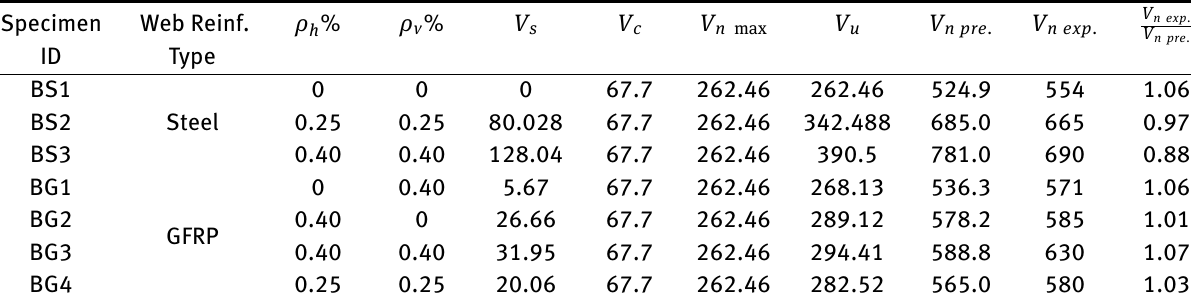
Table 11: Design of deep beams with traditional ACI design method (ACI 318R-99) [17] Specimen Web ID